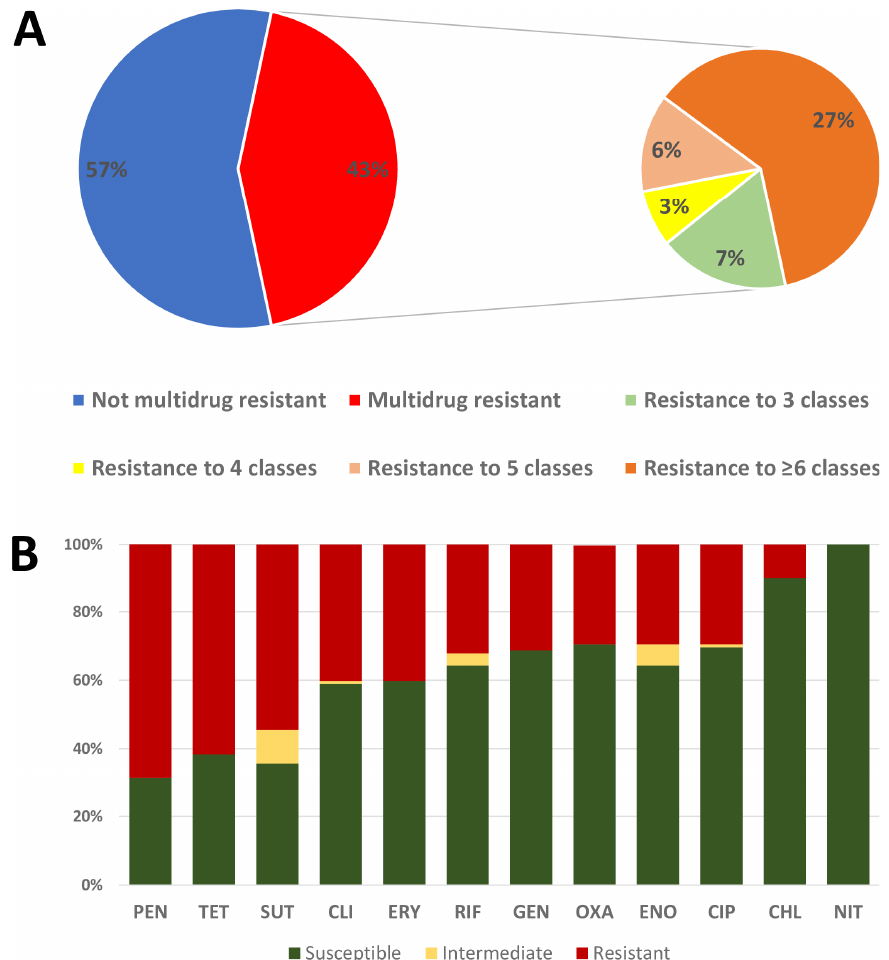
Figure 1. ( A ) Total frequency (%) of multidrug resistant (MDR) staphylococci. ( B ) Percentage of